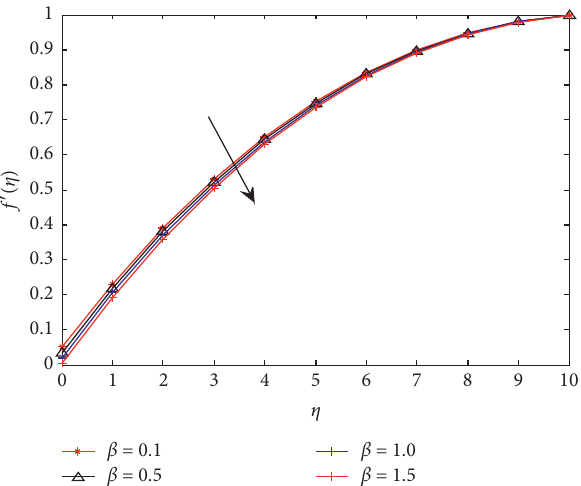
Figure 4: Velocity profile for altered values of β when Pr � 0 . 72, Ω � M � λ � R � s � 1, c � 0 . 2, and Ec � 0 . 1.